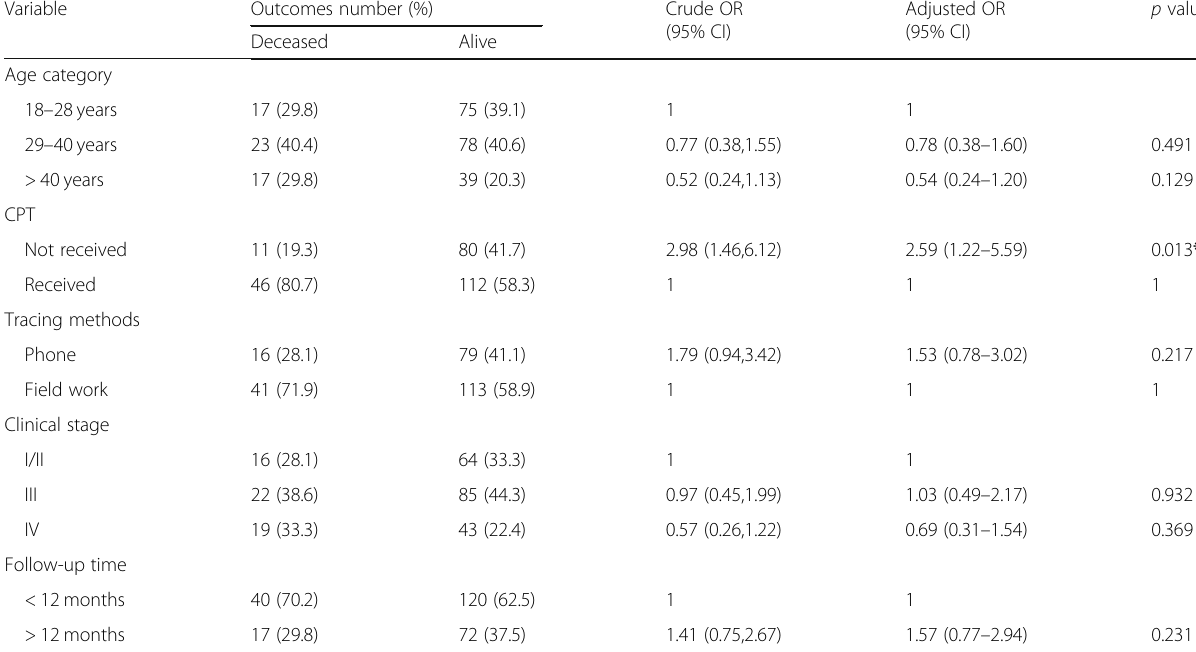
Table 4 Factors associated with mortality of adult HIV-positive patients LTFU